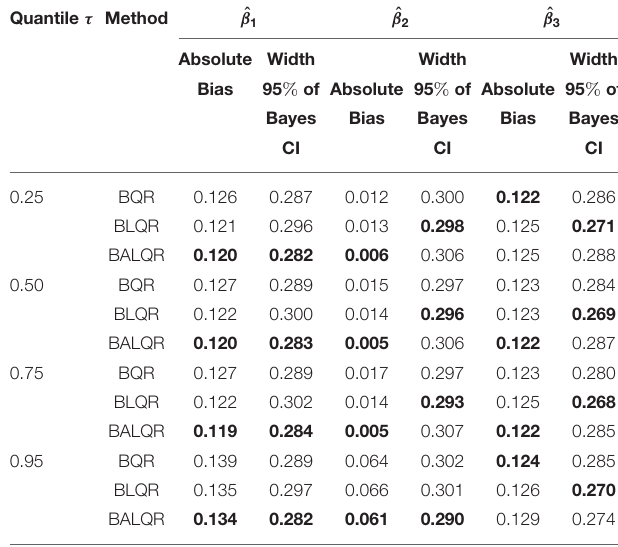
TABLE 2 | The bias and width of 95 % Bayes credible interval for autocorrelated error, e